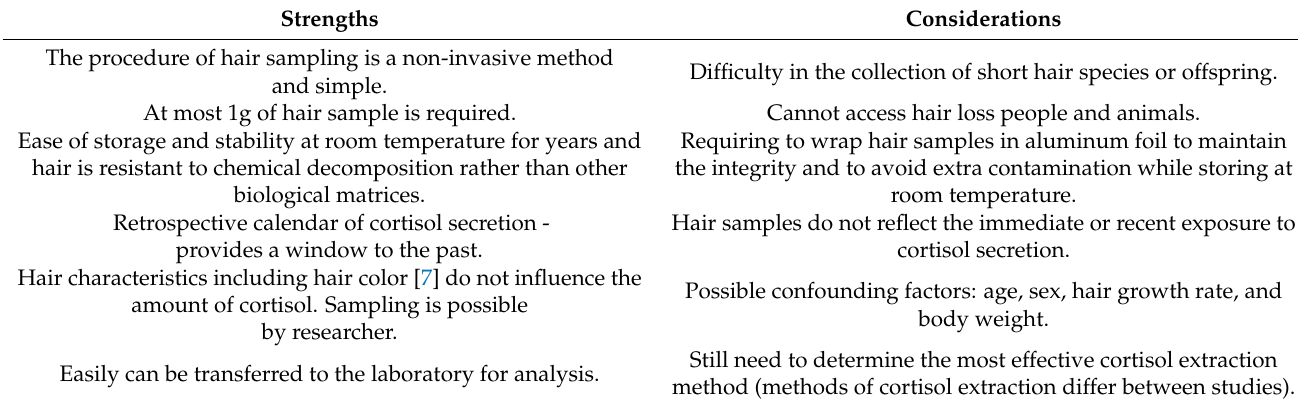
Table 2. * The summary of the capability of the hair matrix for measuring cortisol in